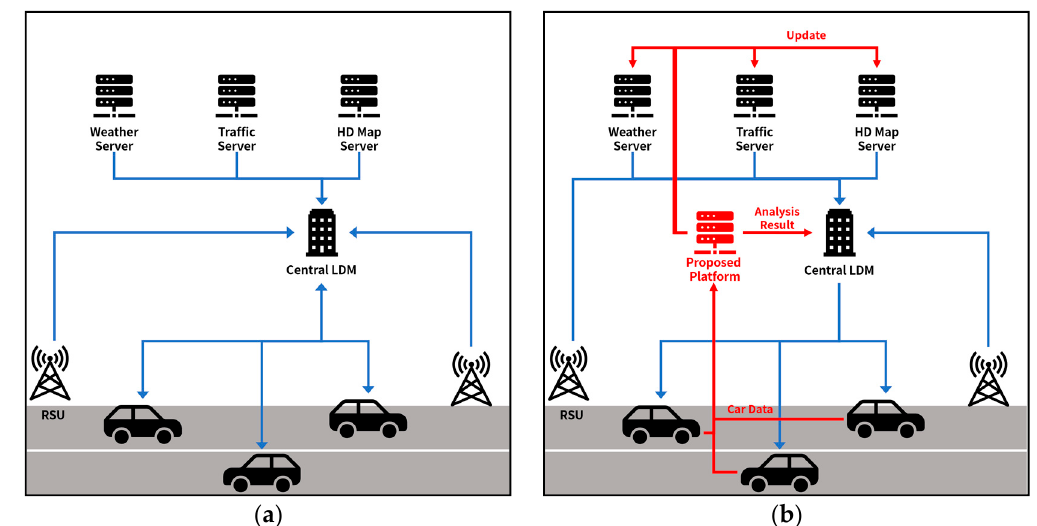
Figure 4. ( a ) Existing C-ITS environment diagram; ( b ) C-ITS environment with the proposed platform diagram.